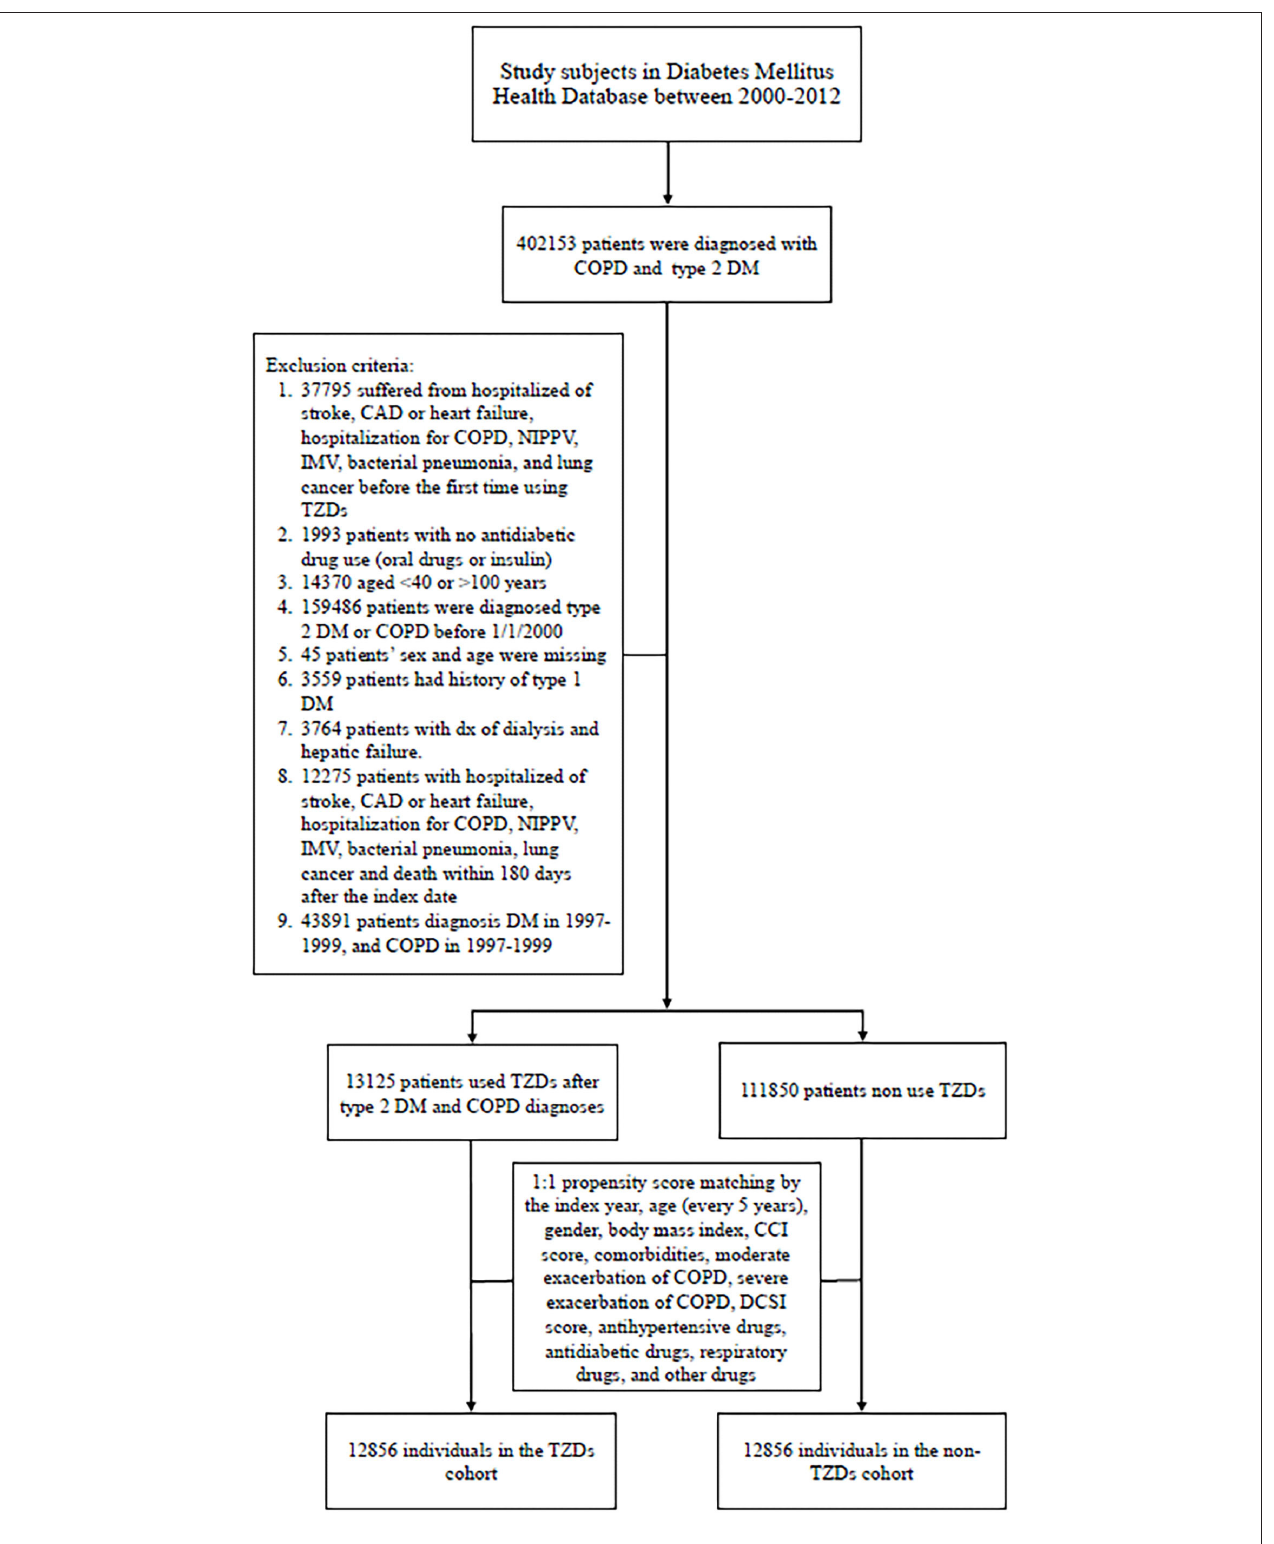
FIGURE 1 | Patient selection